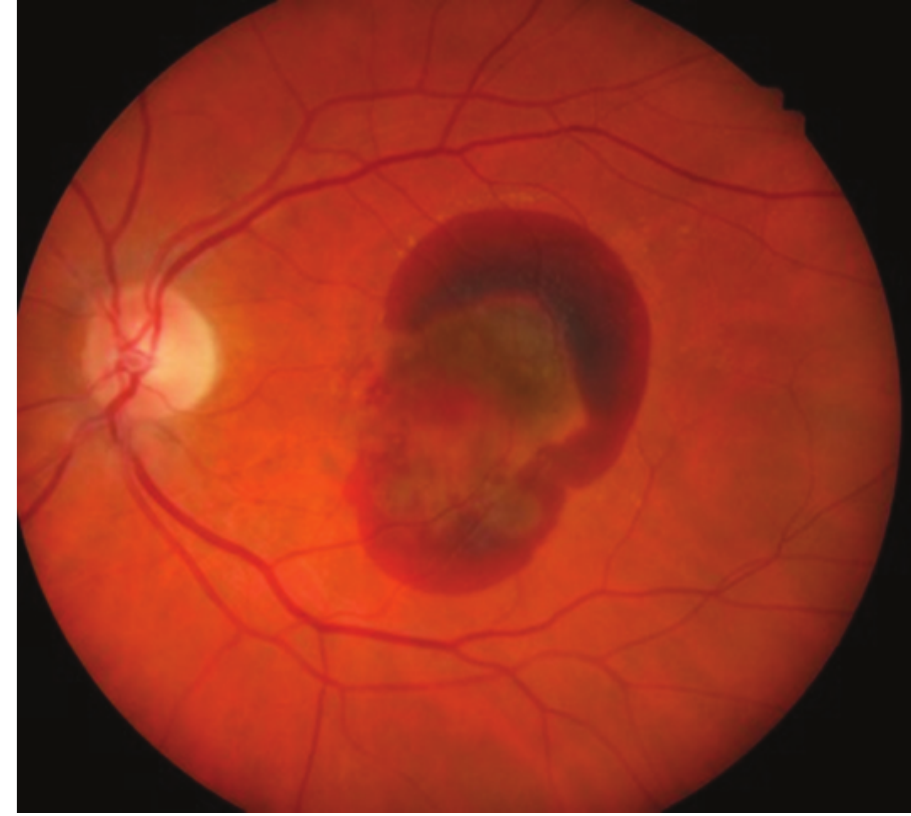
Figure 1. Preoperative color fundus photo demonstrating a large submacular hemorrhage.